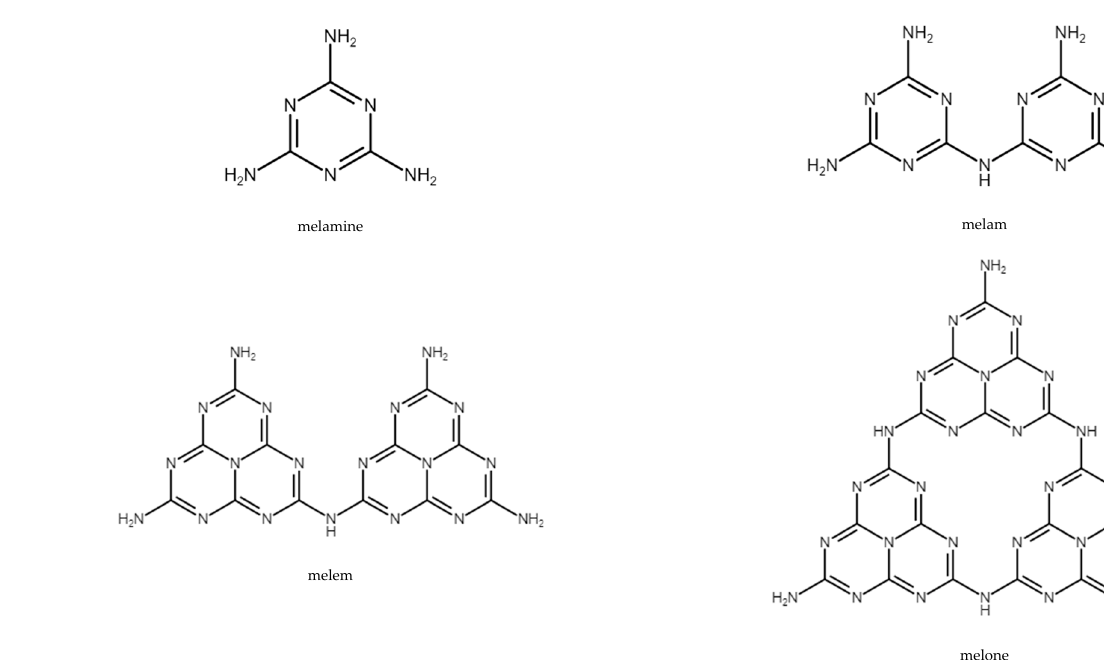
Figure 5. Structures of melamine, melam, melem, and melone [73].